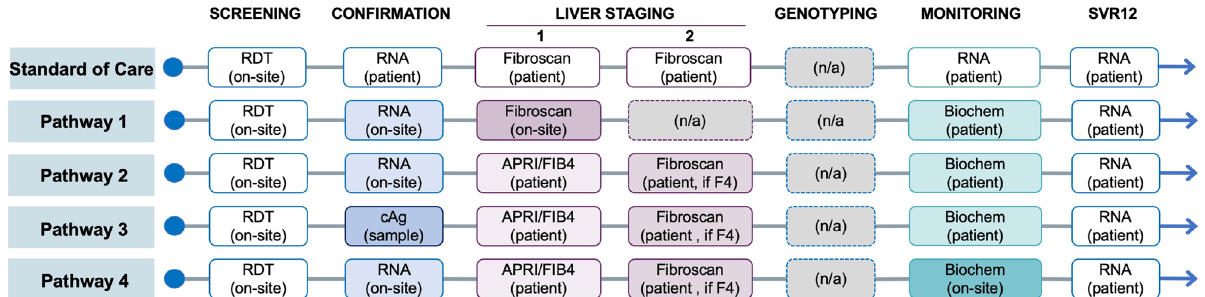
Figure 1. Patient flow under the current standard-of-care testing pathway and innovative hepatitis C testing pathways in Georgia. Abbreviations: RDT, rapid diagnostic test; RNA, ribonucleic acid test; cAg, core antigen test; APRI/FIB4, aspartate aminotransferase (AST)-to-platelet ratio index (APRI)/fibrosis-4 index; F4, METAVIR fibrosis score of 4.